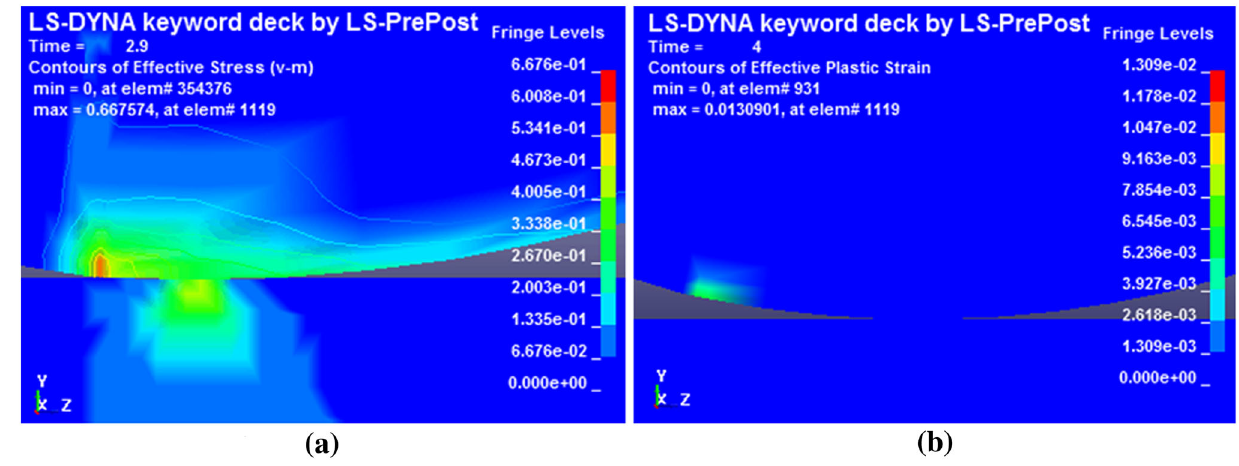
Fig. 5 Von Mises equivalent stress and equivalent plastic strain contours. a Von Mises equivalent stress contour. b Equivalent plastic strain contour